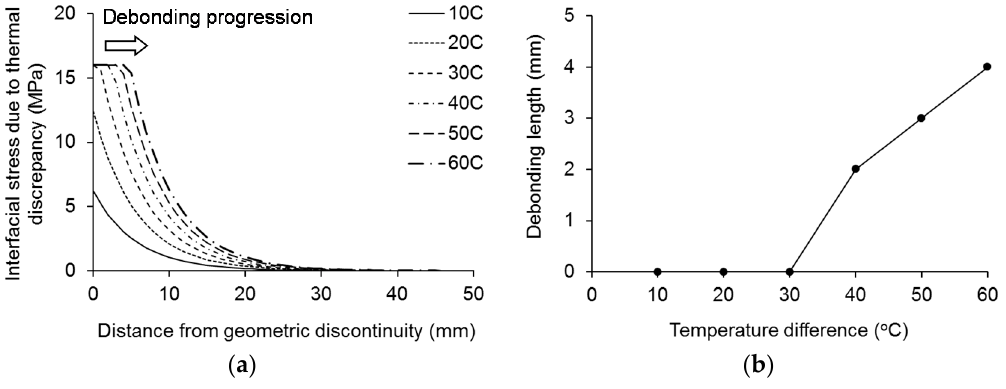
Figure 12. Interfacial stress development depending on temperature difference: ( a ) stress profile; ( b ) initiation and propagation of CFRP debonding.